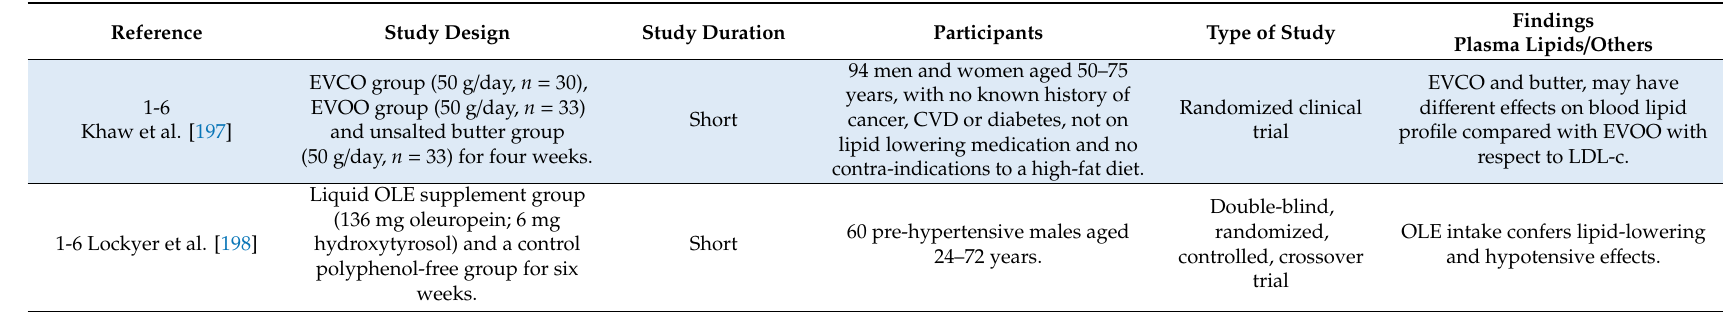
Table 8. Potential protective e ff ect of olives or their bioactive compounds on proinflammatory and oxidative stress markers during the progression of